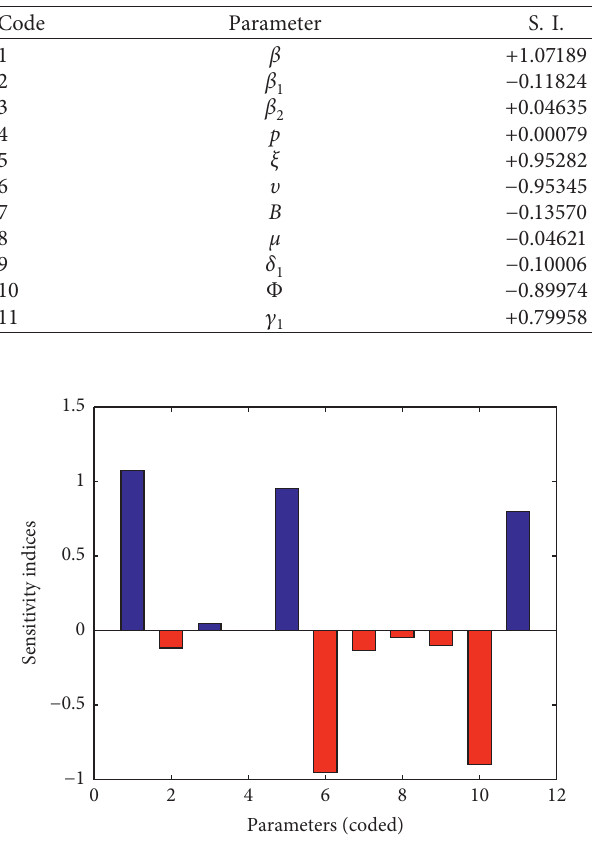
Figure 2: Sensitivity indices/partial rank correlation coefficients , in relation to parameters (PRCC) of R 0